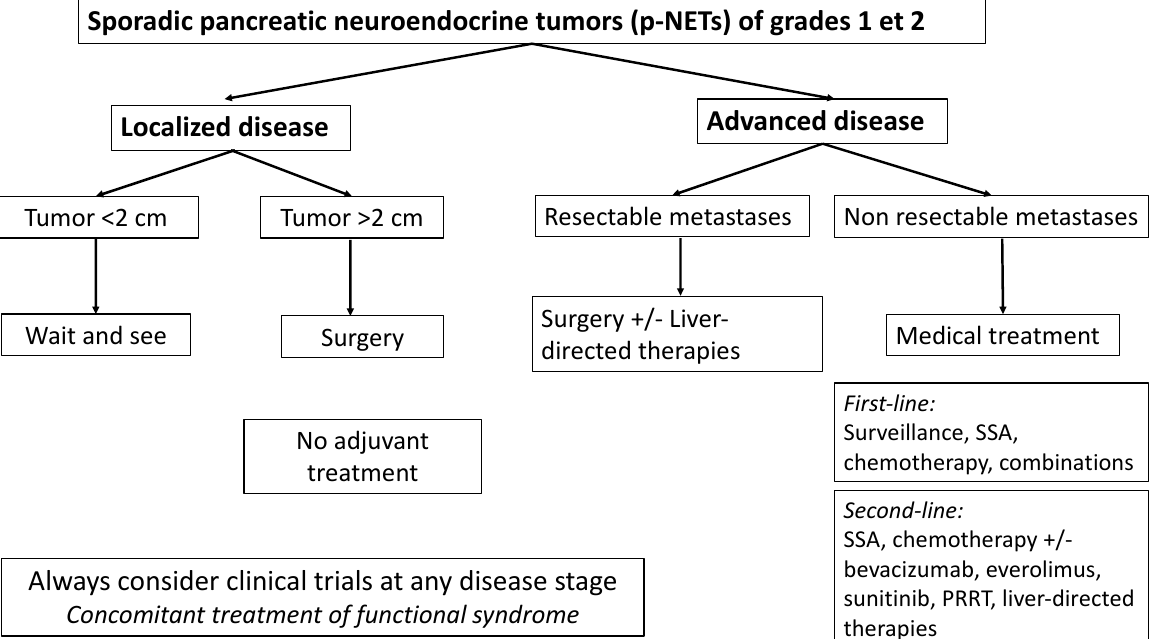
Figure 1. Proposed therapeutic algorithm for sporadic, well-differentiated grade 1 and 2 pancreatic neuroendocrine tumors (p-NETs). SSA: somatostatine analogues, PRRT: Peptide receptor radionucleide therapy.